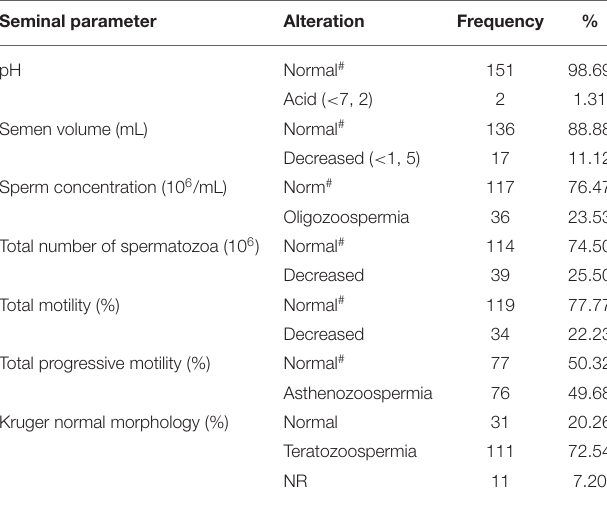
TABLE 3 | Summary of the multiple linear regression analysis model with constant predictors * for hormonal/seminal parameters and testicular